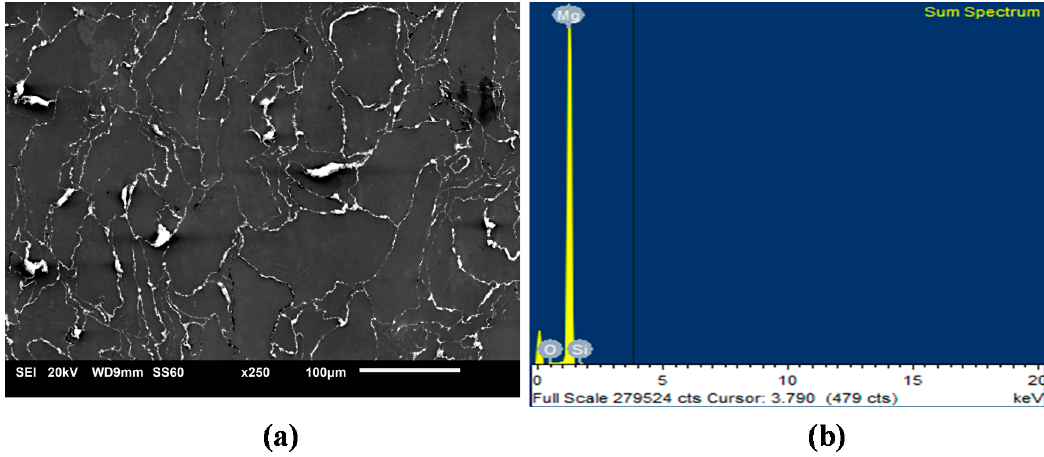
Figure 1. Representative micrographs of ( a ) SiO 2 distribution and ( b ) EDS sum spectrum in representative Mg-1.0 SiO 2 .